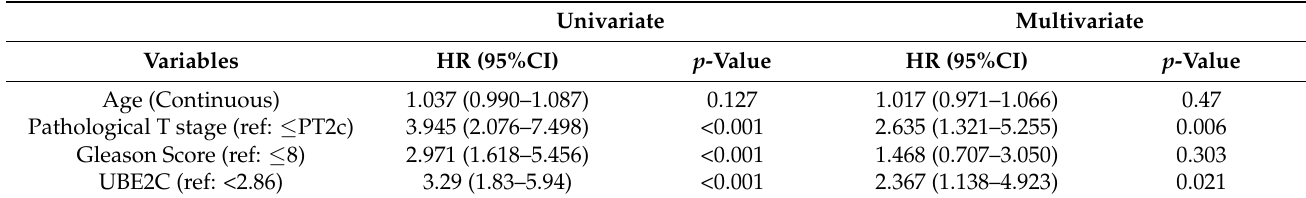
Table 2. Summary of univariate and multivariate analysis for predicting PSA